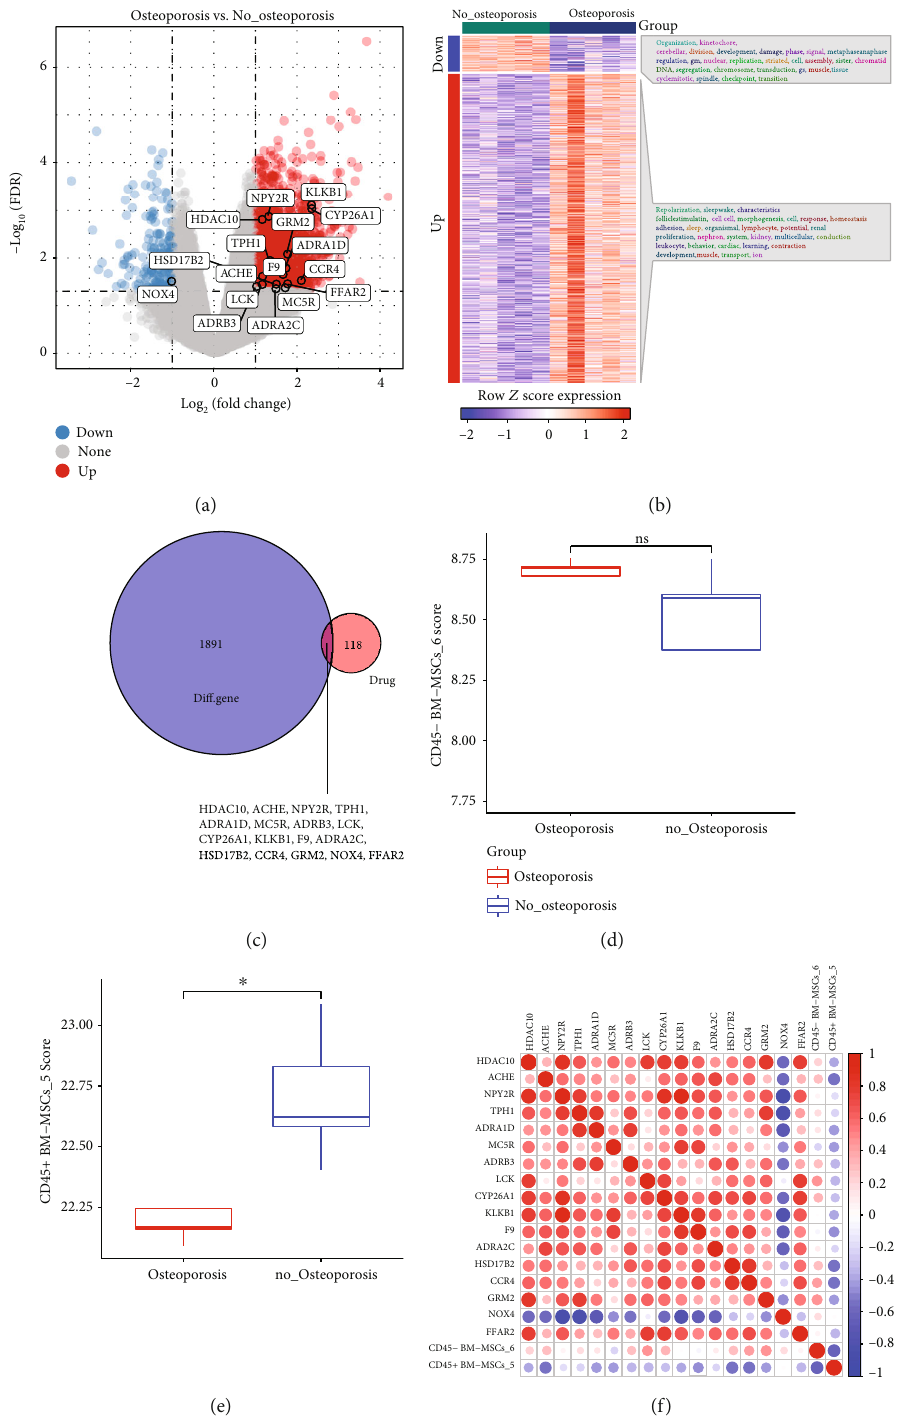
Figure 2: Identi fi cation of hub genes. (a) Volcano plot of di ff erentially expressed genes between osteoporosis and nonosteoporosis. (b) Heatmap of di ff erentially expressed genes between osteoporosis and nonosteoporosis. (c) Venn of di ff erentially expressed genes and target genes for osteoporosis drugs. (d) CD45-BM-MSCs score di ff erences analysis between osteoporosis and nonosteoporosis. (e) CD45 +BM-MSCs score di ff erences analysis between osteoporosis and nonosteoporosis. (f) The correlation analysis between 17 hub genes and CD45-BM-MSCs subpopulation or CD45+BM-MSCs